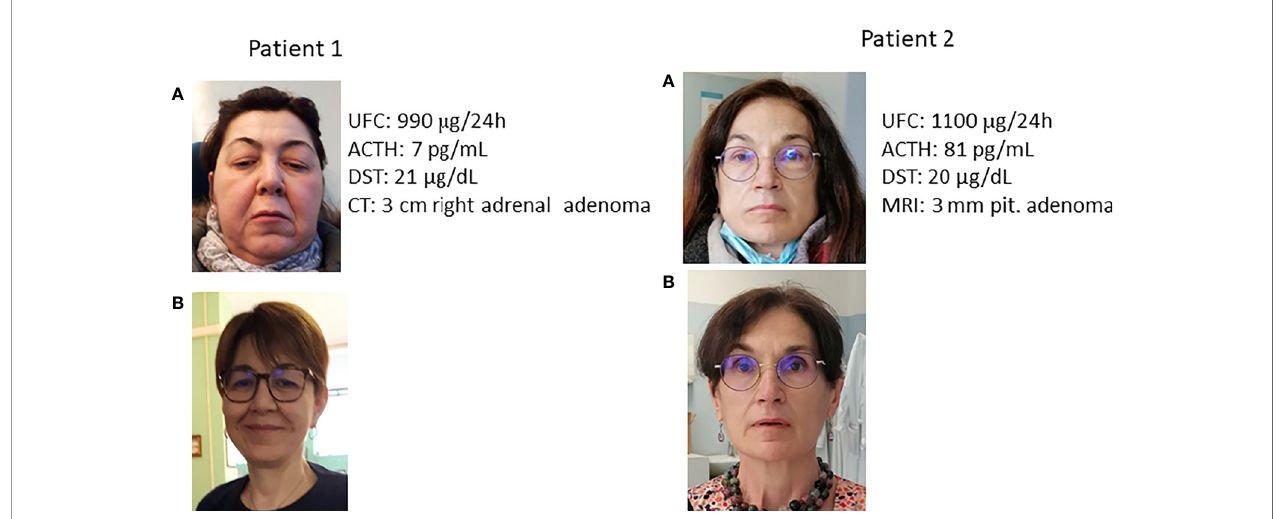
FIGURE 1 | Clinically overt Cushing syndrome and occult hypercortisolism. (A) at diagnosis; (B) after cure. UFC: urinary free cortisol (normal values 20-137 m g/24h); ACTH: adrenocorticotroph hormone (normal values 5-55 pg/mL); DST: cortisol after 1 mg overnight dexamethasone suppression test (normal values <1.8 m g/dL); MRI: Magnetic Resonance Imaging; CT computed tomography. Patient 1: Clinically overt Cushing syndrome. The patient was referred for the clinical picture and the presence of spontaneous vertebral fracture. Note the typical facies plethorica. Patient 2: Occult hypercortisolism. The patient was referred for resistant